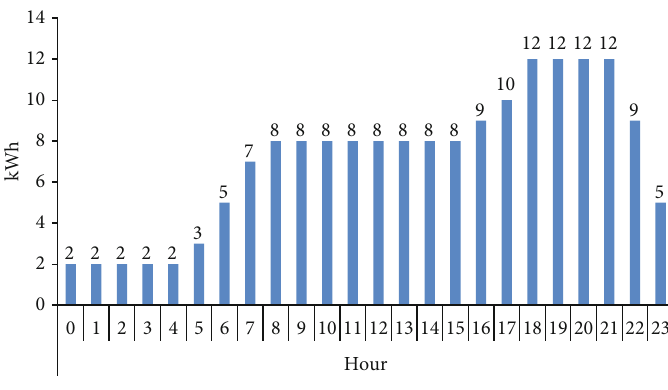
Figure 14: Daily load pro fi le of the PV solar minigrid with storage.